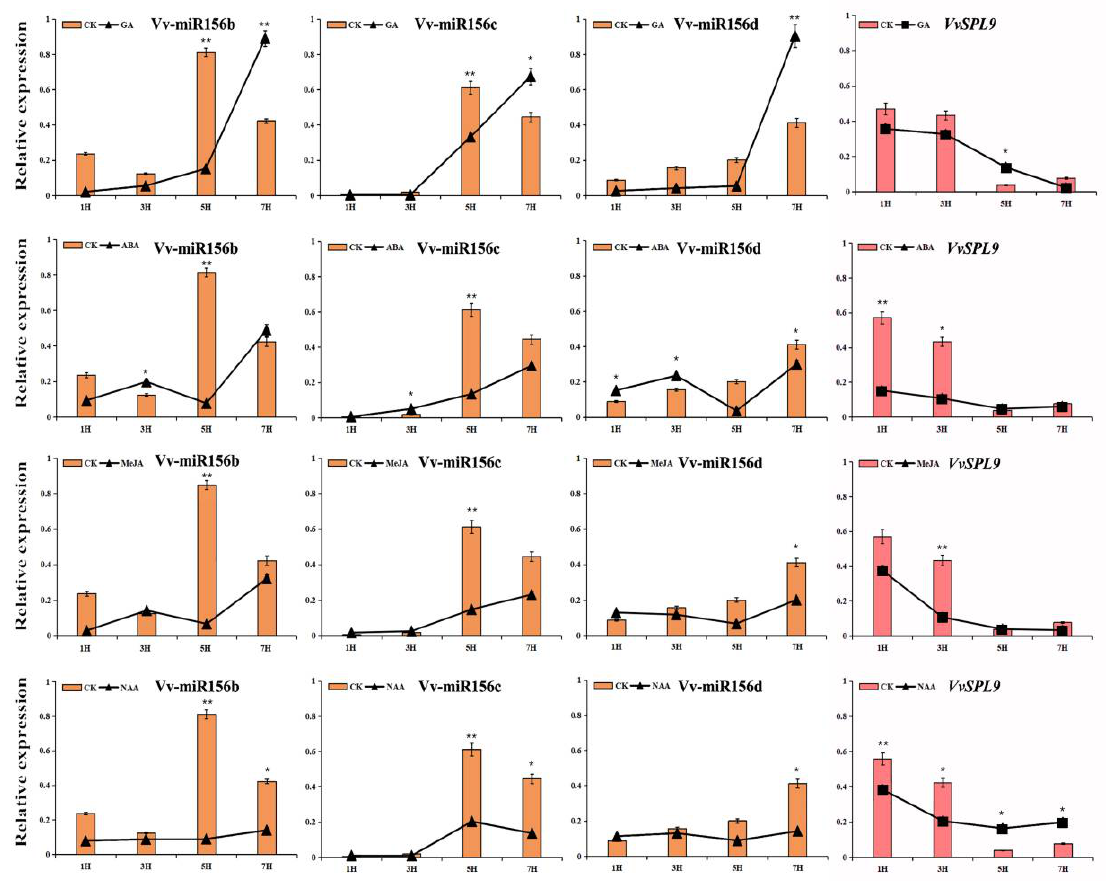
Figure 4. Differential expression of VvmiR156b/c/d and their VvSPL target genes in response to different hormone treatments at different time points [1 h after treatment (1HAT), 3HAT, 5HAT, 7HAT] of leaf development. Asterisks indicated statistically significant differences at (* p < 0.05; ** p < 0.01) as determined